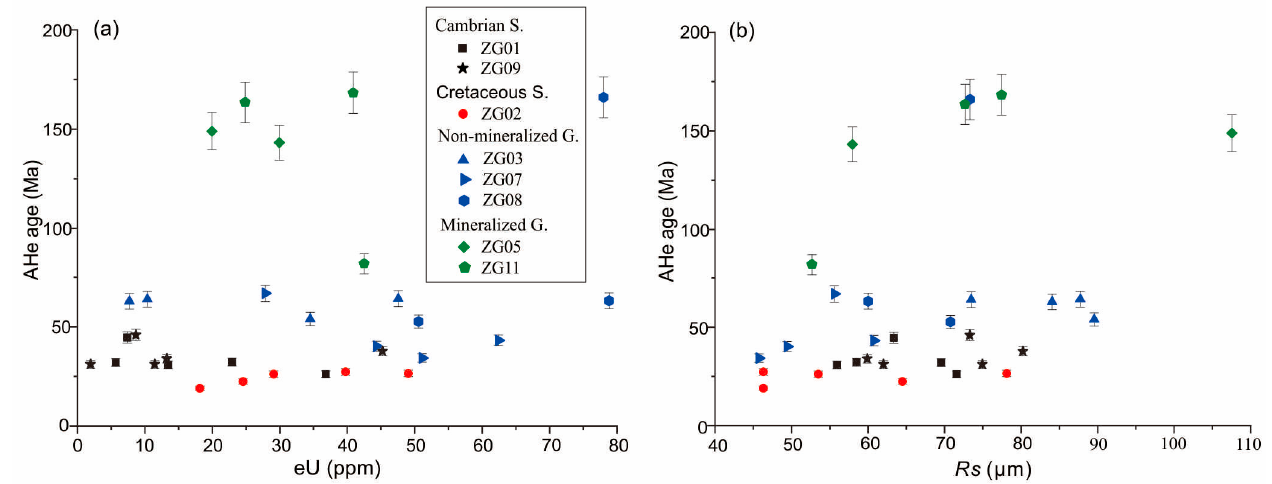
Figure 5. ( a ) Plots of AHe ages versus effective uranium (eU) content and ( b ) equivalent spherical radius ( Rs ) for Lujing uranium ore field samples. S. = sandstone, G. = granite.